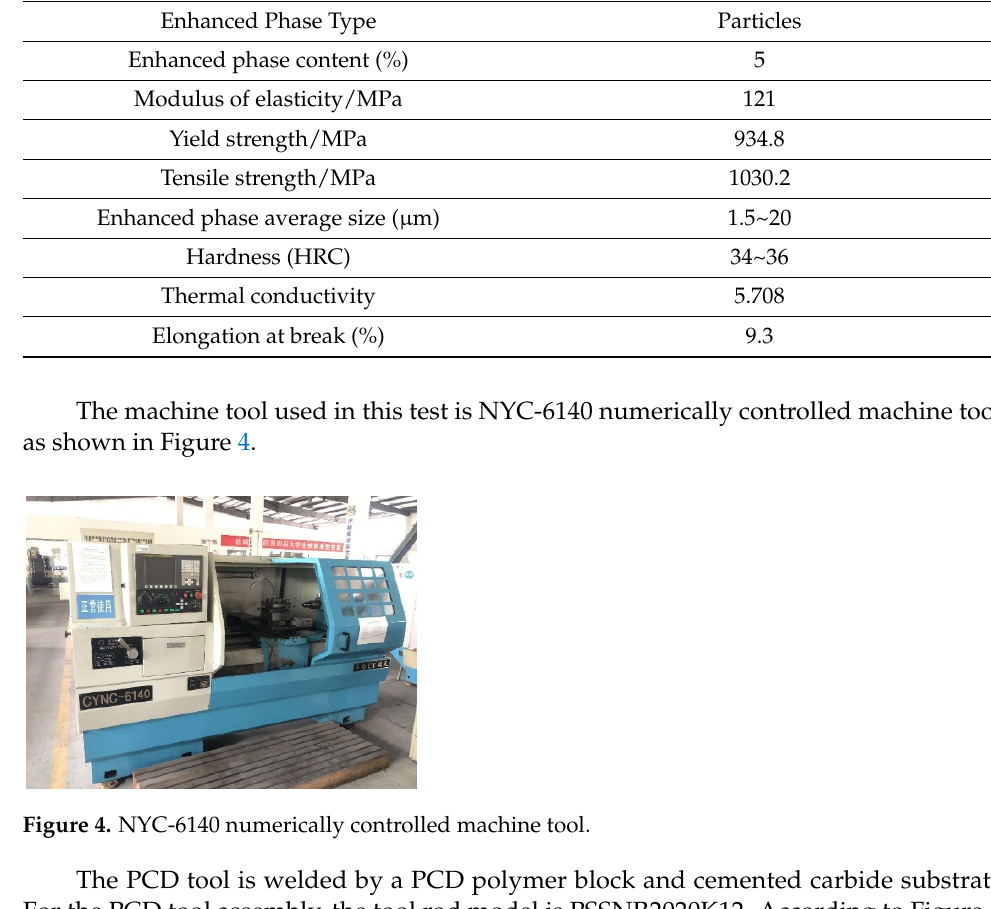
Table 4. Physical and mechanical properties of titanium matrix composites [27].